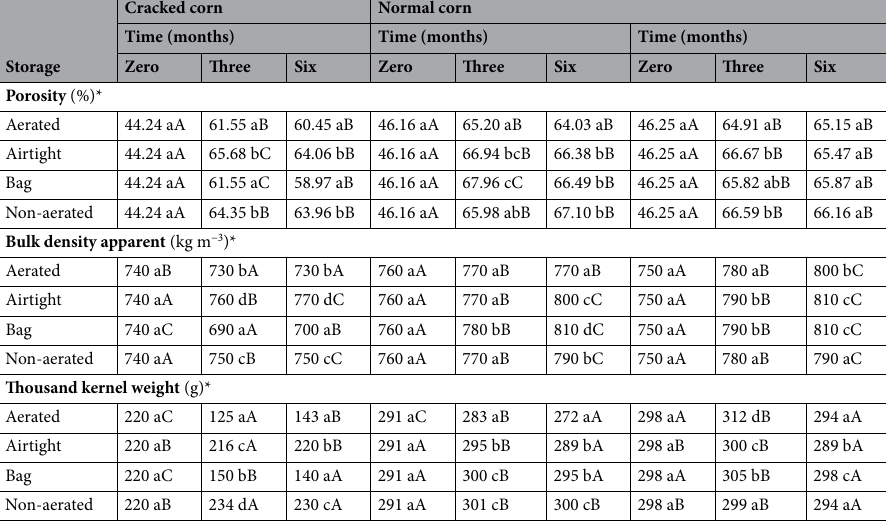
Table 2. Alterations in the physical mass of shelled corn stored under different systems and durations. *Means followed by the capital letter in the line for each storage time and lowercase in the column for each storage form, do not differ at 5% probability.